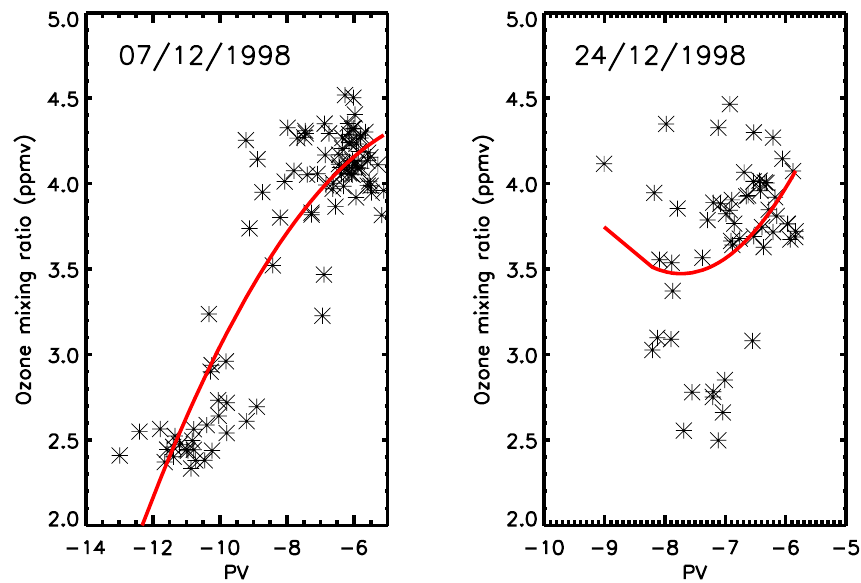
Fig. 2. Ozone mixing ratio (in ppmv) and PV (in 10 − 5 · Kkg − 1 m 2 s − 1 ) for the Southern Hemisphere POAMIII measurements on the 600K isentropic surface, for two days, 7 December (left) and 24 December (right) 1998. The red line represents the quadratic